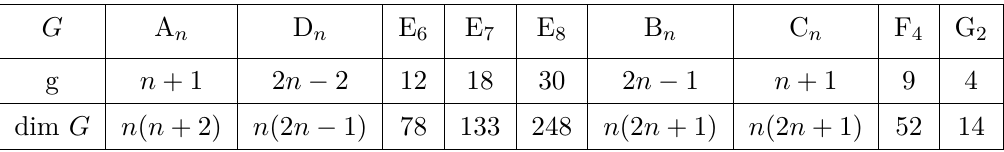
Table 10 . Dual Coxeter number g and dimension of the gauge group G